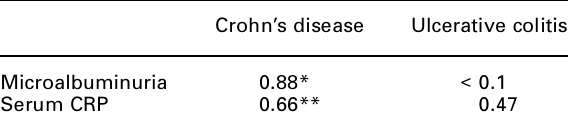
Table 1. Correlation coefficient ( r ) between urinary nitrite and markers of disease activity (microalbuminuria and